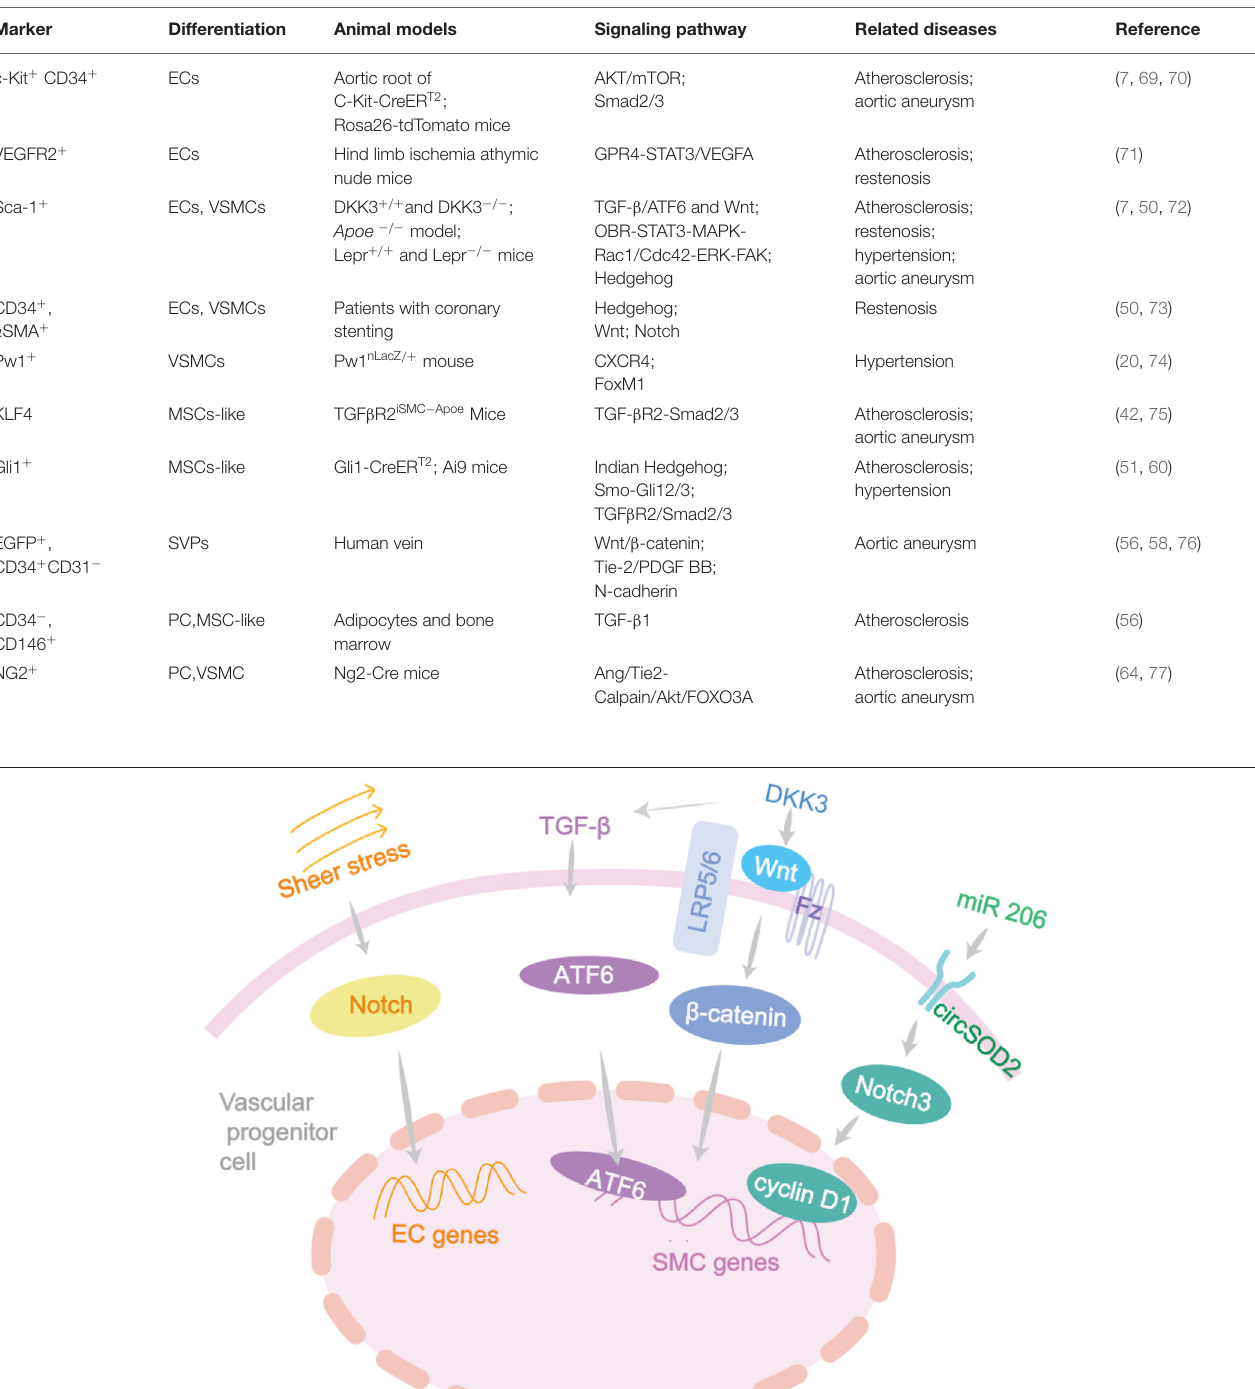
TABLE 2 | Markers and signaling pathways of vascular wall stem cells and related diseases. Marker